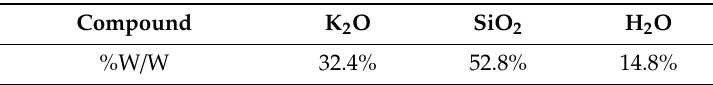
Table 2. Chemical composition of K 2 SiO 3.